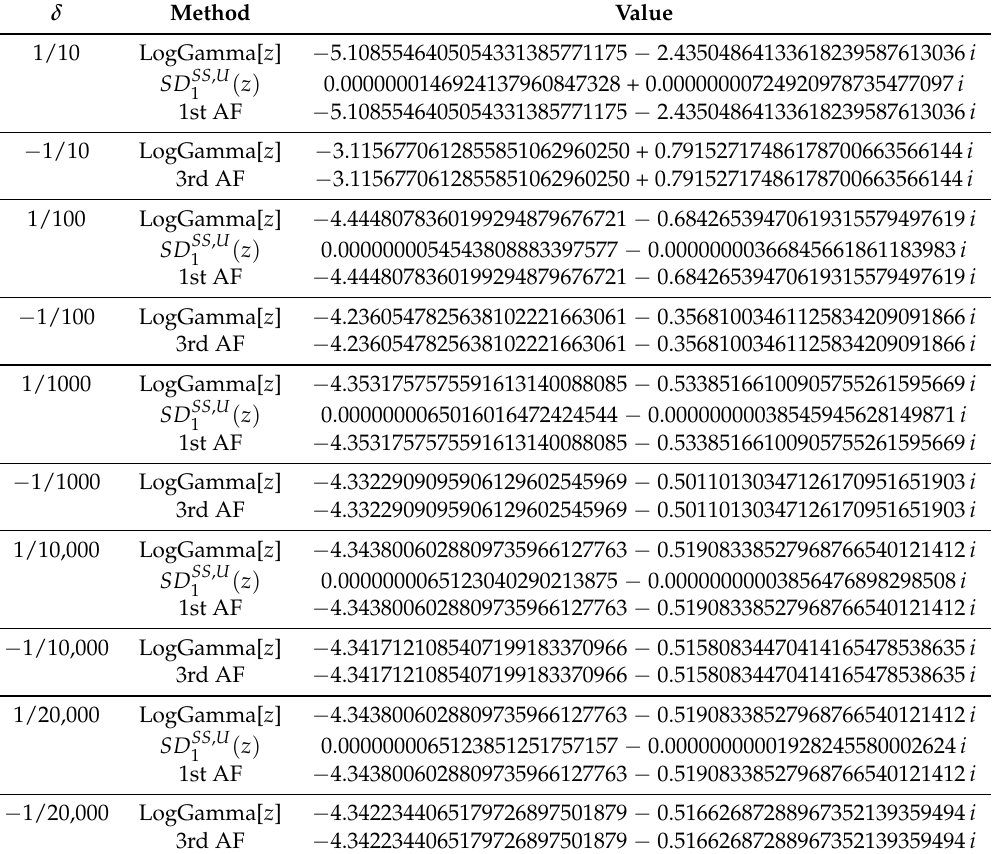
Table 5. ln Γ ( 3exp ( i ( 1/2 + δ ) π )) via (24) for various values of δ